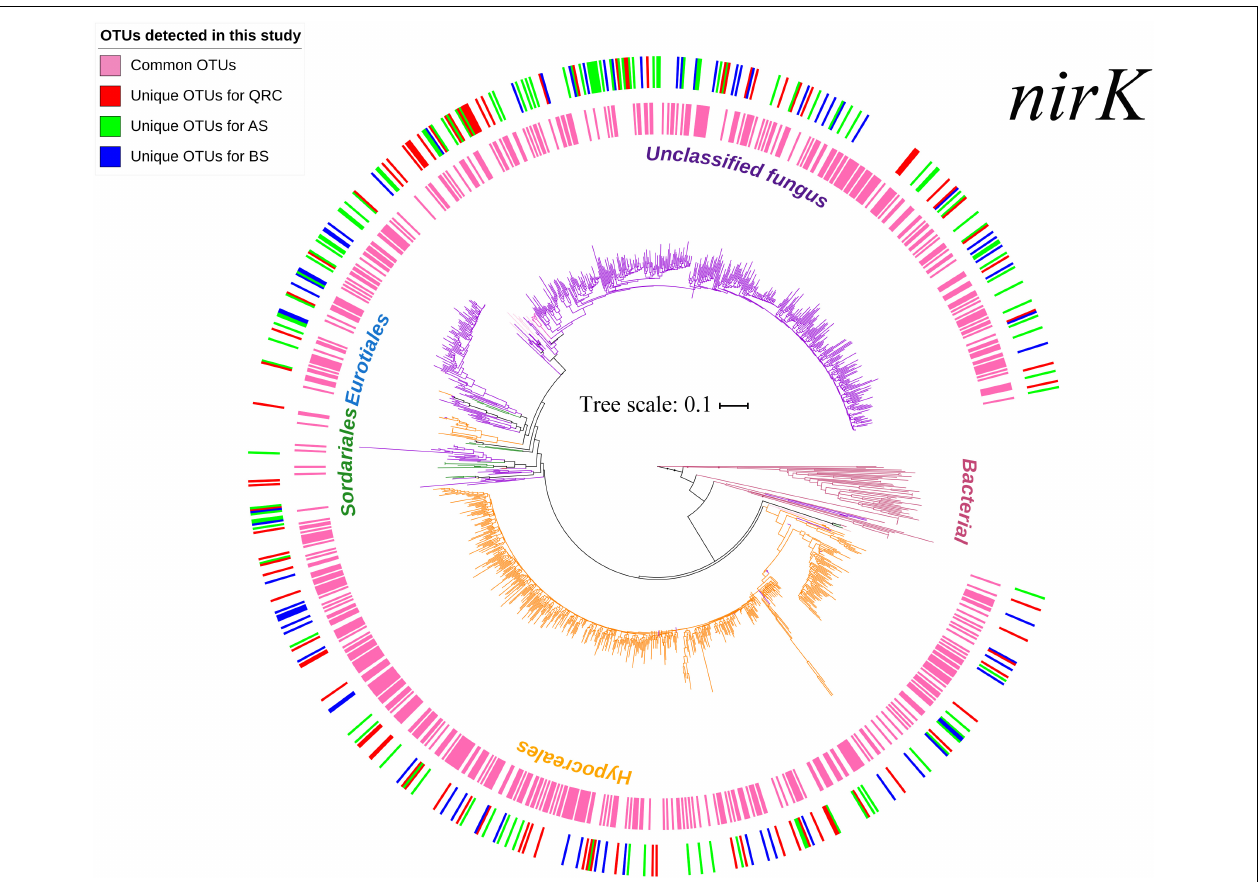
FIGURE 1 | Neighbor-joining tree based on fungal nirK amino-acid sequences. Branches in different colors represent different fungal orders. Sequences originated from this study are highlighted with different colors in the circles, with the inner circles represent the common OTUs across the three soil types, and the outer circles represent the unique OTUs in different soil types. Different colors in the outer circles represent unique OTUs in different soils: Red-unique OTUs in QRC; Green-unique OTUs in AS; Blue-unique OTUs in BS. AS, alluvial soils; BS, black soils; QRC, quaternary red clay soils.